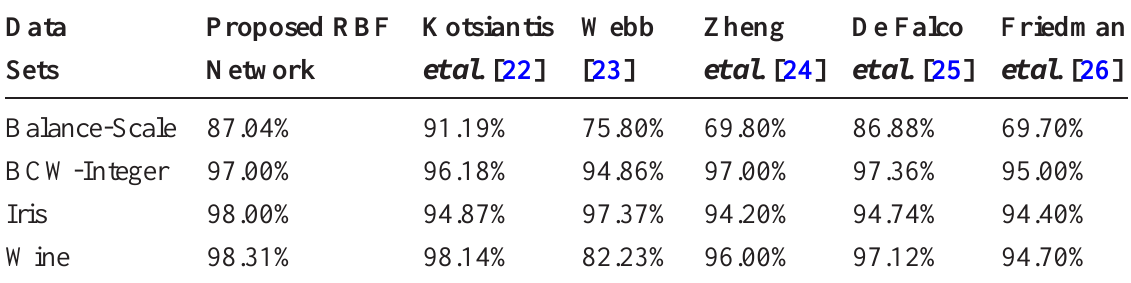
Table 4. The CSRs of various classifiers for datasets from the UCI database repository [21].